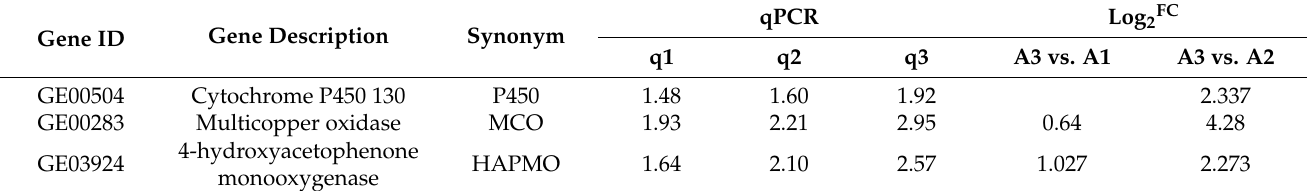
Table 1. BPA-degrading genes in strain R-001.